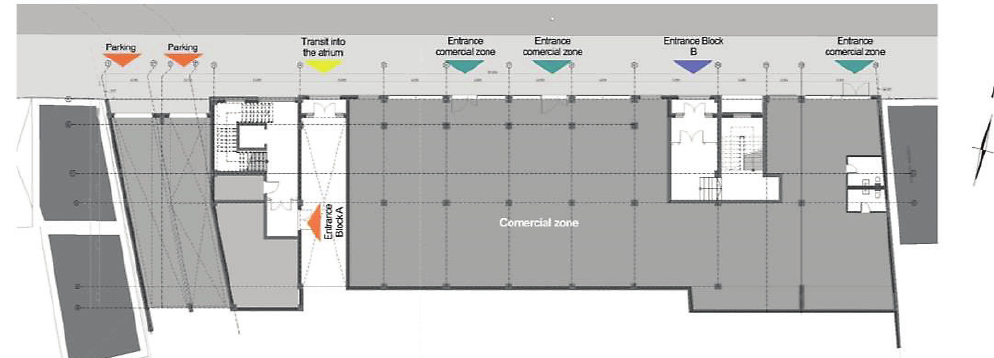
Figure 6. Incoming zone plan (source: Design proposition by author,